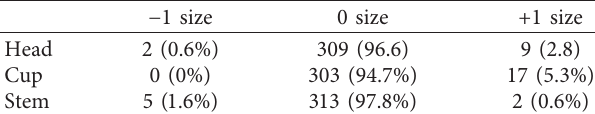
Table 2: Component size accuracy of